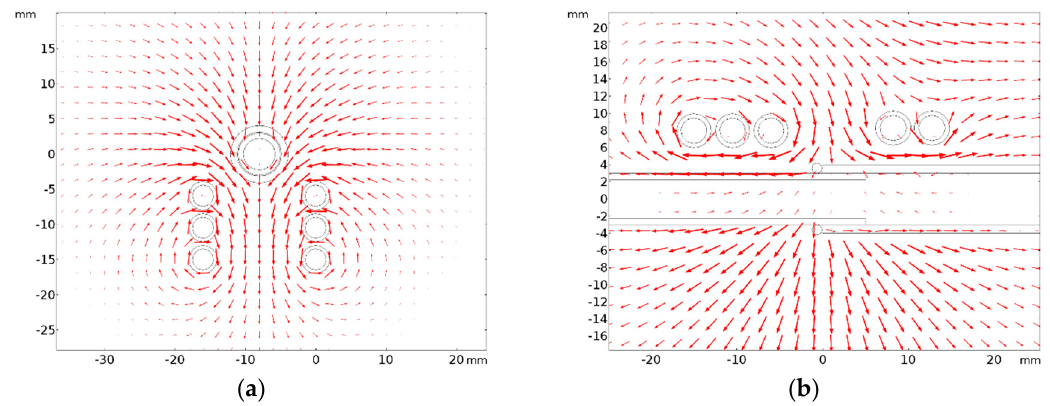
Figure 4. Magnetic flux vector—coil and brazing assembly, ( a ) top view, ( b ) side view.